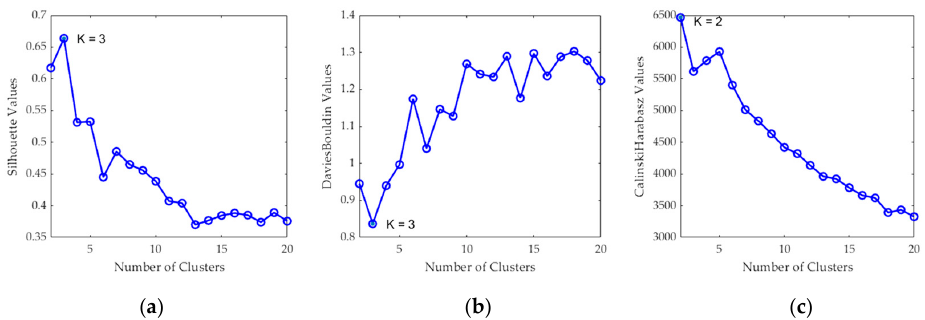
Figure 7. Clustering evaluation to segment the normal skin training dataset. Results of the optimal cluster number evaluation using the following methods: ( a ) Silhouette (maximum K indicates optimal value), ( b ) Davies Bouldin (minimum K indicates optimal value) and ( c ) Calinski Harabasz (maximum K indicates optimal value).